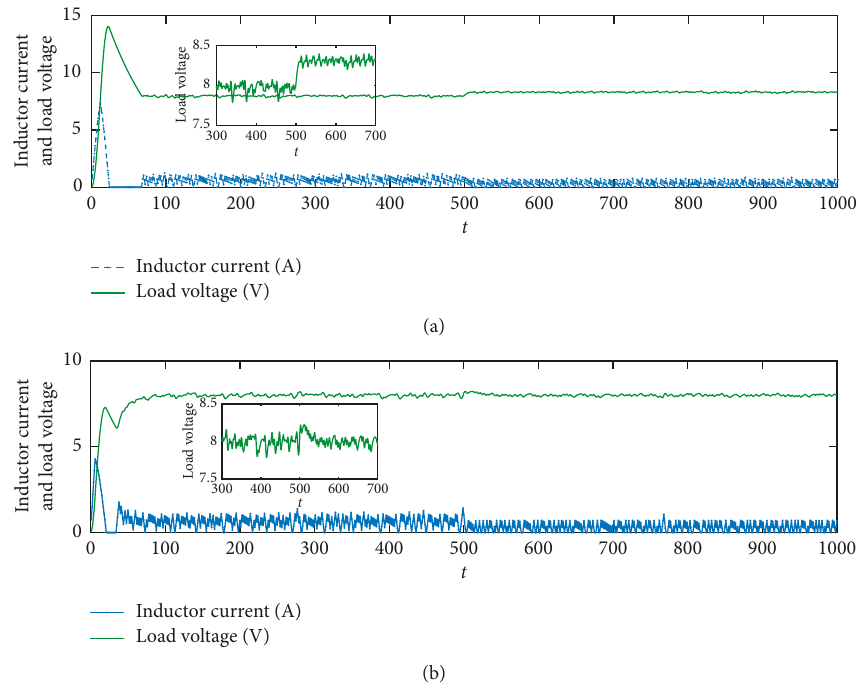
Figure 11: Comparison of MSMLD method (a) and MSMLD with PI controller method